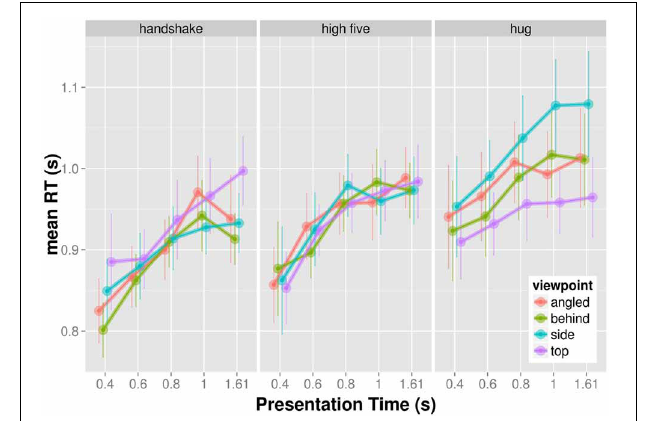
FIGURE 2 | Mean reaction times as a function of presentation time shown for each action and viewpoint